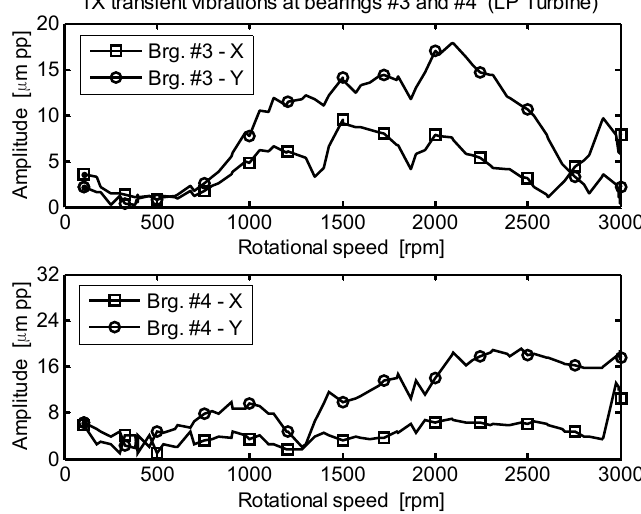
Fig. 6. Amplitude of the 1X vibrations of the LP turbine plotted against the rotational speed: data collected during the reference runup.